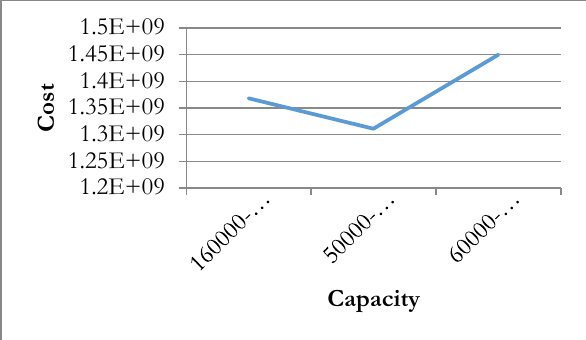
Fig. 8. Analysis of the impact of distribution centers’ capacity on cost.